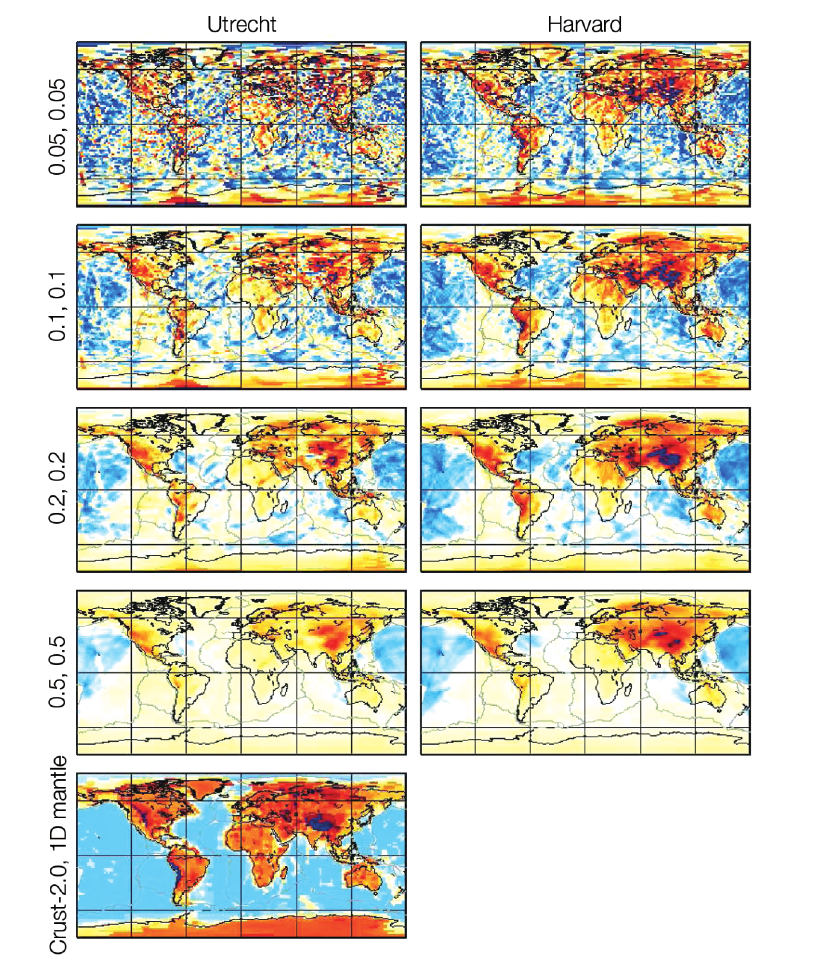
Fig. 3. Love wave dispersion data at 35 s, from both Trampert and Woodhouse’s (2001) ( left ) and Ekström et al. ’s (1997) ( right ) databases, are inverted with four different regularization schemes. Roughness and Norm damping parameters, always coincident in this experiment, are given to the left of each couple of maps. The bot- tom panel shows a theoretical 35 s Love phase velocity map: at each pixel of Crust-2.0, local mode eigenfunc- tions were used to calculate the phase velocity resulting from a spherically symmetric mantle and heterogeneous crust. We do not expect tomographic and theoretical maps to concide, but they should share some prominent fea- tures. The colour scale is the same as in fig.